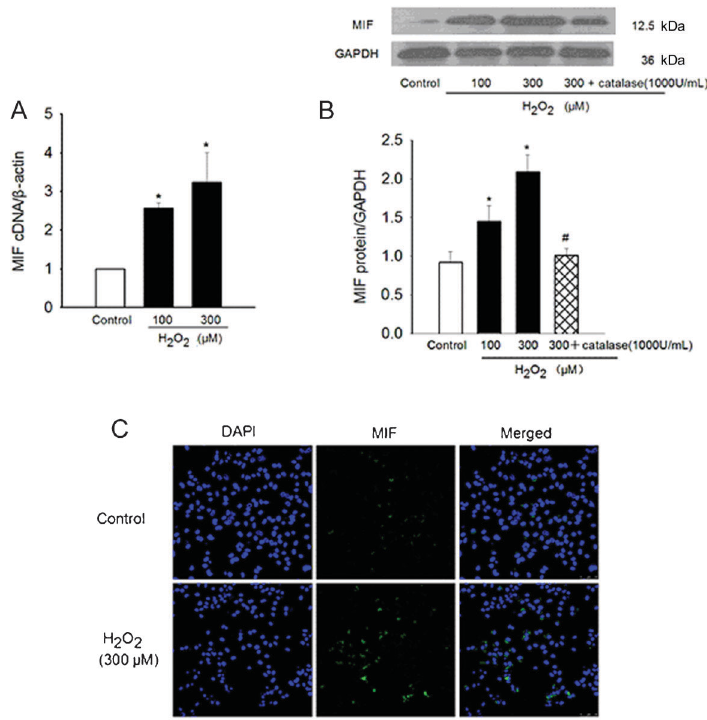
Figure 2. H 2 O 2 -stimulated migration inhibitory factor (MIF) production in HL-1 cells. A , B , HL-1 cells were stimulated by H 2 O 2 (100 or 300 m M) for 6 h or by H 2 O 2 (300 m M) for 6 h in the presence of catalase (1000 U/mL). Levels of MIF mRNA and protein were analyzed using real-time PCR or Western blotting with b -actin or GAPDH as internal controls, respectively. Mean values for each group were determined from 3 separate experiments each performed in duplicate. *P , 0.05 vs control. # P , 0.01 vs 300 m M H 2 O 2 group (one-way ANOVA). C , Immunostaining results of MIF stimulated by 300 m M H 2 O 2 detected by confocal microscope. HL-1 cells were co-stained with anti-MIF antibody, and DAPI. Merged images of MIF (green), and DAPI (blue) staining are